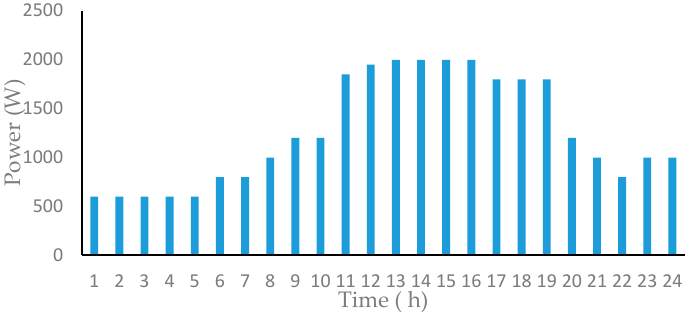
Figure 3. Hourly solar irradiation (in an average year) and detail for a specific day at the grid location .